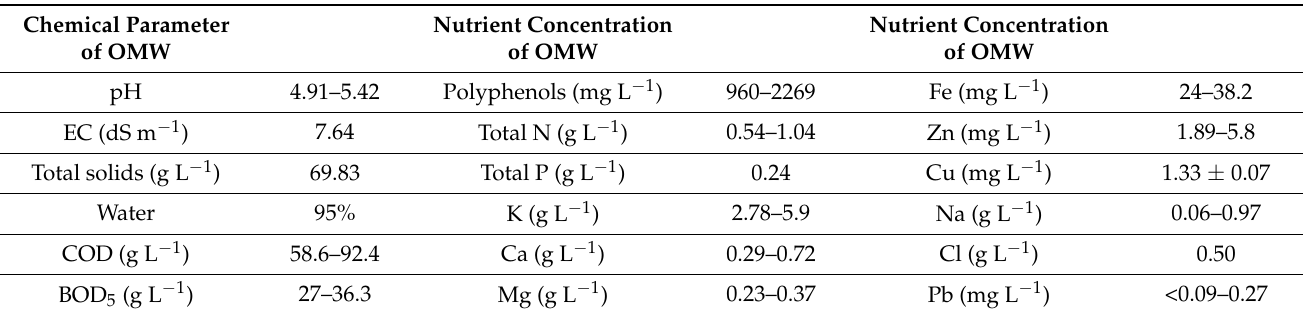
Table 1. Range of chemical properties of untreated (raw) olive mill wastewater (OMW) (from Ayoub et al., 2014; Vella et al., 2016)